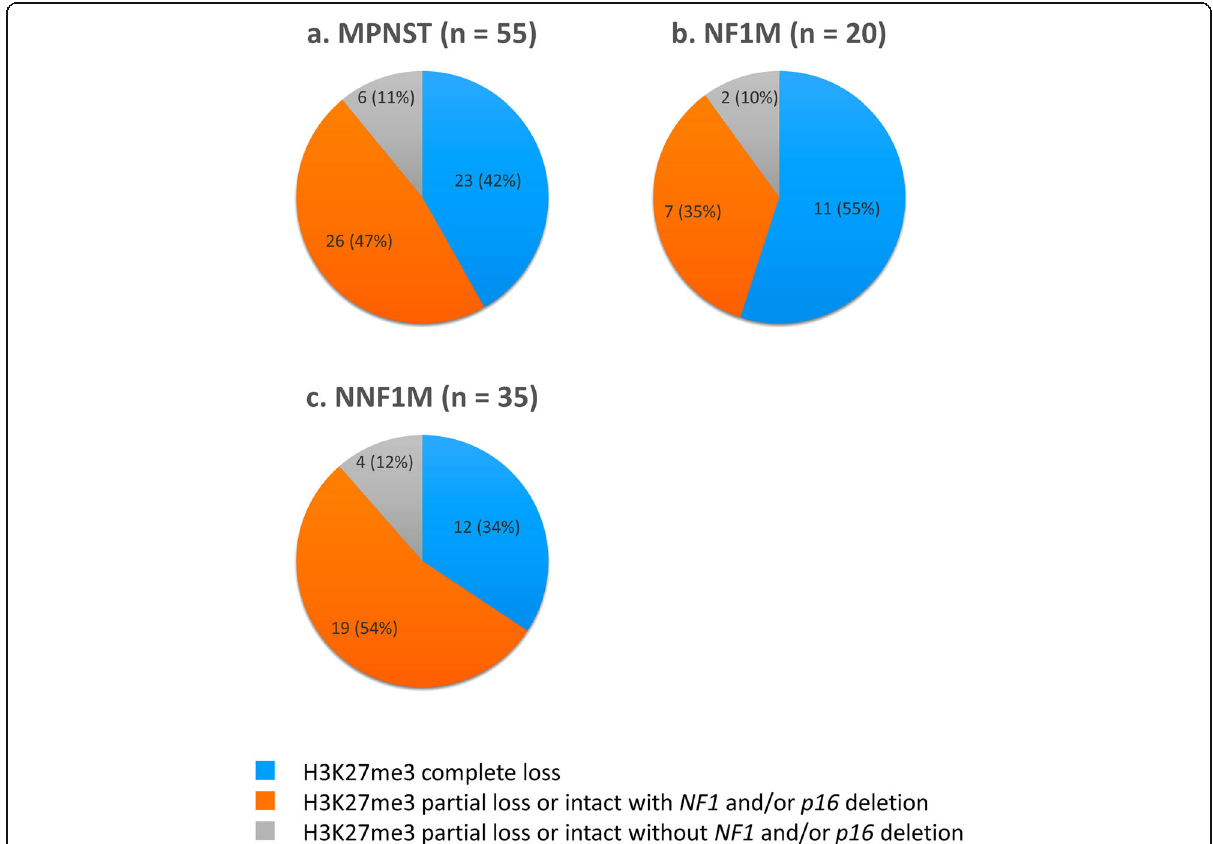
Fig. 2 Combination of immunohistochemistry for histone 3 trimethylated on lysine 27 (H3K27me3) and fluorescence in situ hybridization for neurofibromatosis 1 ( NF1 ) and p16 deletion in malignant peripheral nerve sheath tumor (MPNST) cases. a . Status of H3K27me3 loss and NF1 and/ or p16 deletion in all MPNST cases. A majority of MPNST cases had H3K27me3 complete loss and H3K27me3 partial loss or intact with NF1 and/or p16 deletion. b . Status of H3K27me3 loss and NF1 and/or p16 deletion in neurofibromatosis 1 (NF1)-associated MPNST (NF1M) cases. c . Status of H3K27me3 loss and NF1 and/or p16 deletion in non-NF1 associated MPNST (NNF1M)